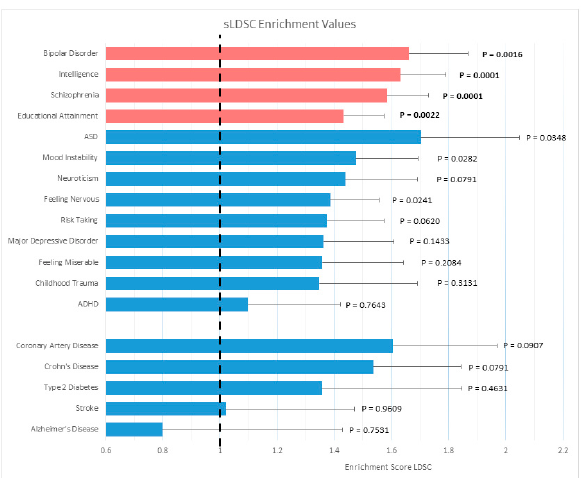
Figure 3. Heritability enrichment analysis of the SORCS3 gene-set stratified linkage disequilibrium score regression (sLDSC). Test (top) and control (bottom) phenotypes are plotted on the y-axis. Enrichment values (proportion of h2/proportion of # SNPs), where an enrichment score of 1 indicates no enrichment, are plotted on the x-axis, with error bars representing standard error and p-values displayed. Phenotypes where the p-value remains significant after Bonferroni correction are shown in red. Full results of the sLDSC analysis are located in Supplementary Table